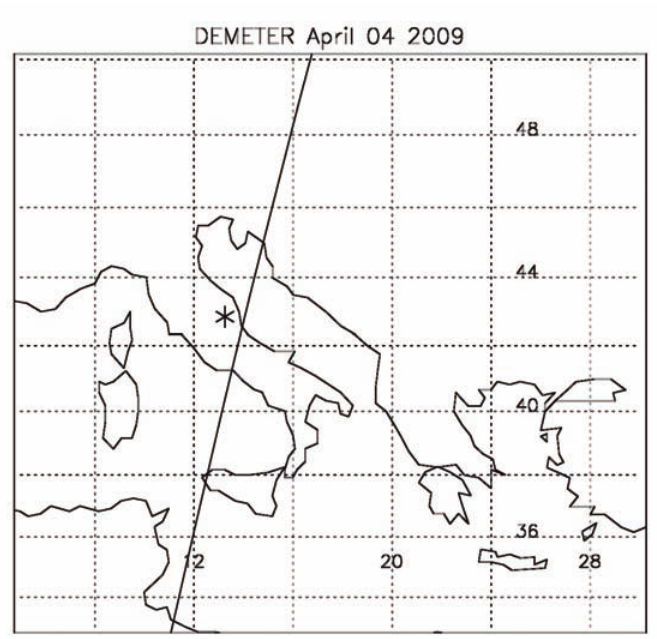
Figure 6. Map showing the epicenter of the April 6 L’Aquila earthquake (*) and the orbit of the DEMETER satellite on April 4, 2009. The point of closest approach from the epicenter was 125 km.